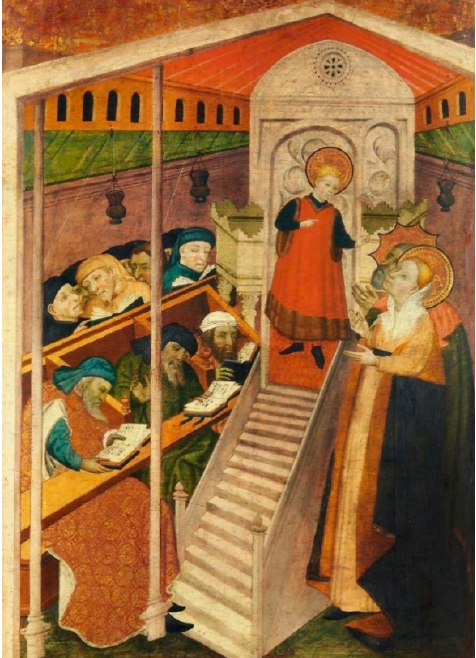
Figure 14. Jesus among the Doctors, panel from a Spanish altarpiece, early fifteenth century. Courtesy of Metropolitan Museum of Art.